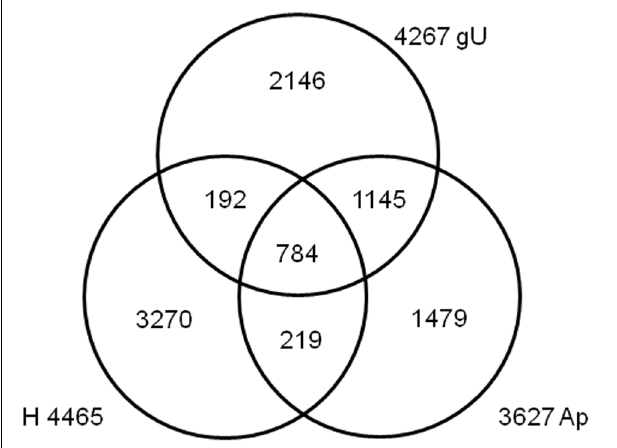
FIGURE 1 | Venn diagram depicting the comparison of Hemileia vastatrix EST libraries, using a best reciprocal BLAST hit strategy. Number of contigs is indicated for the germinating urediniospores (gU), appressoria (Ap) and infected leaves 21 days after inoculation (H) libraries.